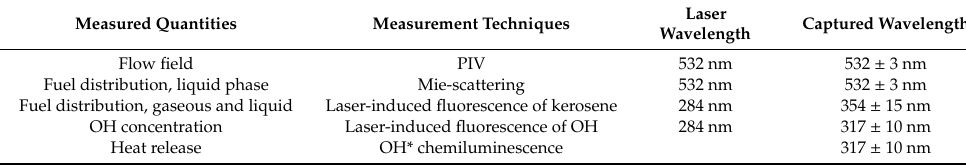
Table 2. Summary of applied optical techniques.